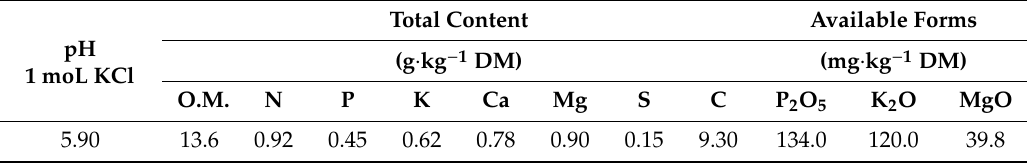
Table 1. Soil reaction and soil nutrient content at the experimental site.